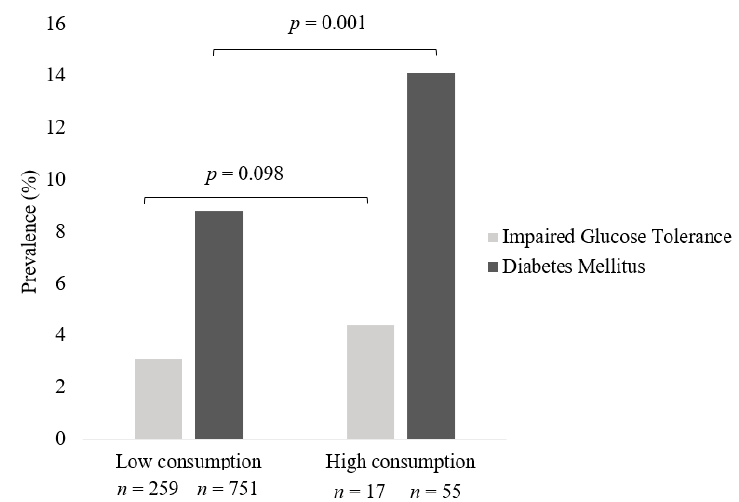
Figure 3. Prevalence of IGT and Diabetes across frequency of processed meat intake in All Meat Eaters in Australian women from the Australian Longitudinal Study on Women’s Health. Pearson chi-square test was used to compare prevalence of disease across groups. Data are presented as percentages. Low consumption encompasses individuals who consumed processed meat ≤ 1/week up to but less than daily and high consumption those who consumed processed meat daily/multiple times per day.